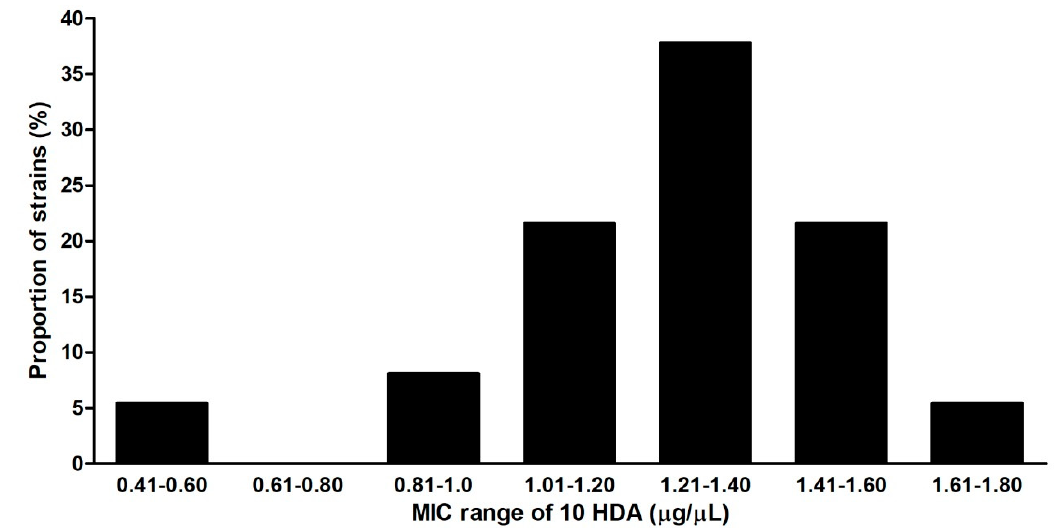
Figure 3. Frequency of P. larvae strains having different MICs in a group of strains with ERIC I and ERIC II genotypes. Table 2. Antibacterial efficacy of 10-HDA on vegetative cells and spores of P. larvae . Strain